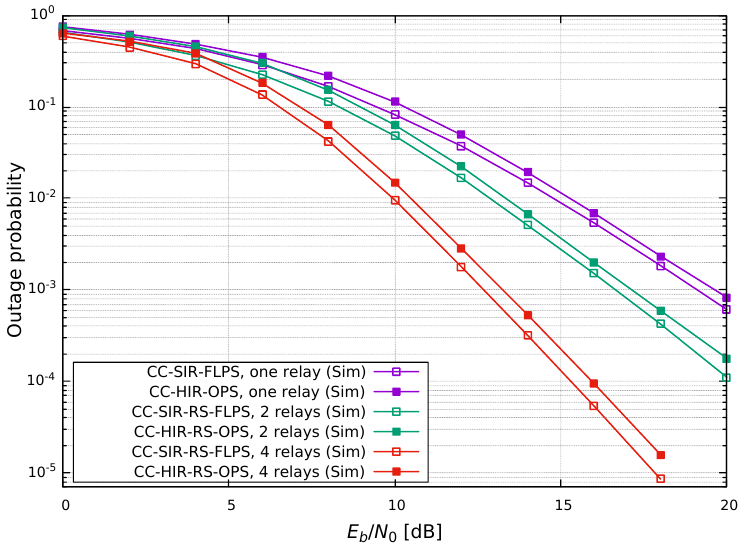
Figure 7. Comparison between the simulated outage probability results versus SNR per infor- mation bit E b / N 0 at the destination of the CC-HIR-RS-OPS and CC-SIR-RS-FLPS schemes for R = 0.5